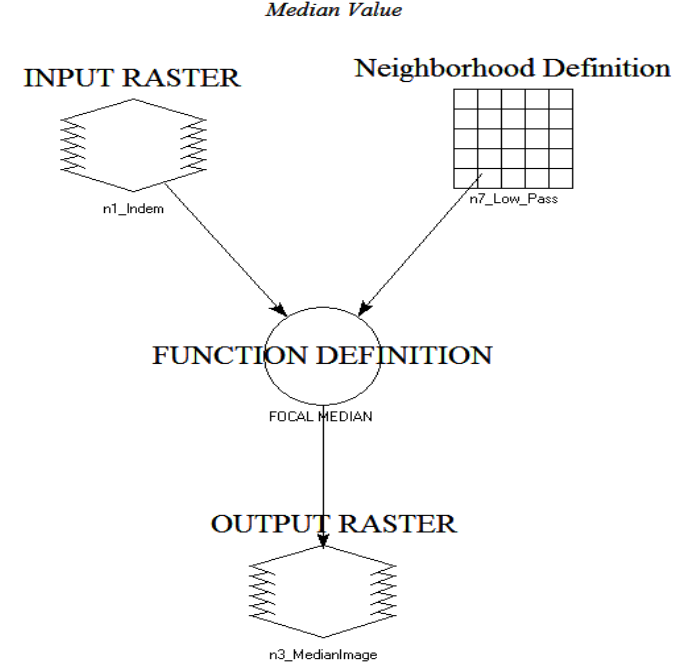
Fig.3: Describe the focal analysis process to handle Landsat images that contain scan line corrector [8].